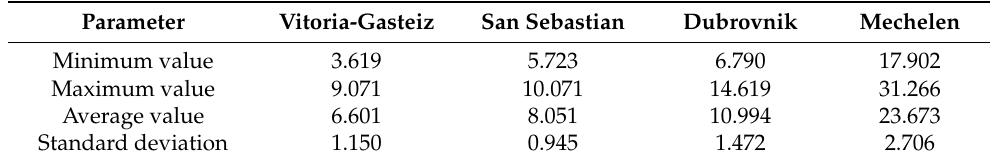
Table 5. Parameters of the CO 2 transport emissions for the scenario when cargo bicycles are used to replace traditional vehicles for deliveries of small-size packages [kg/day].